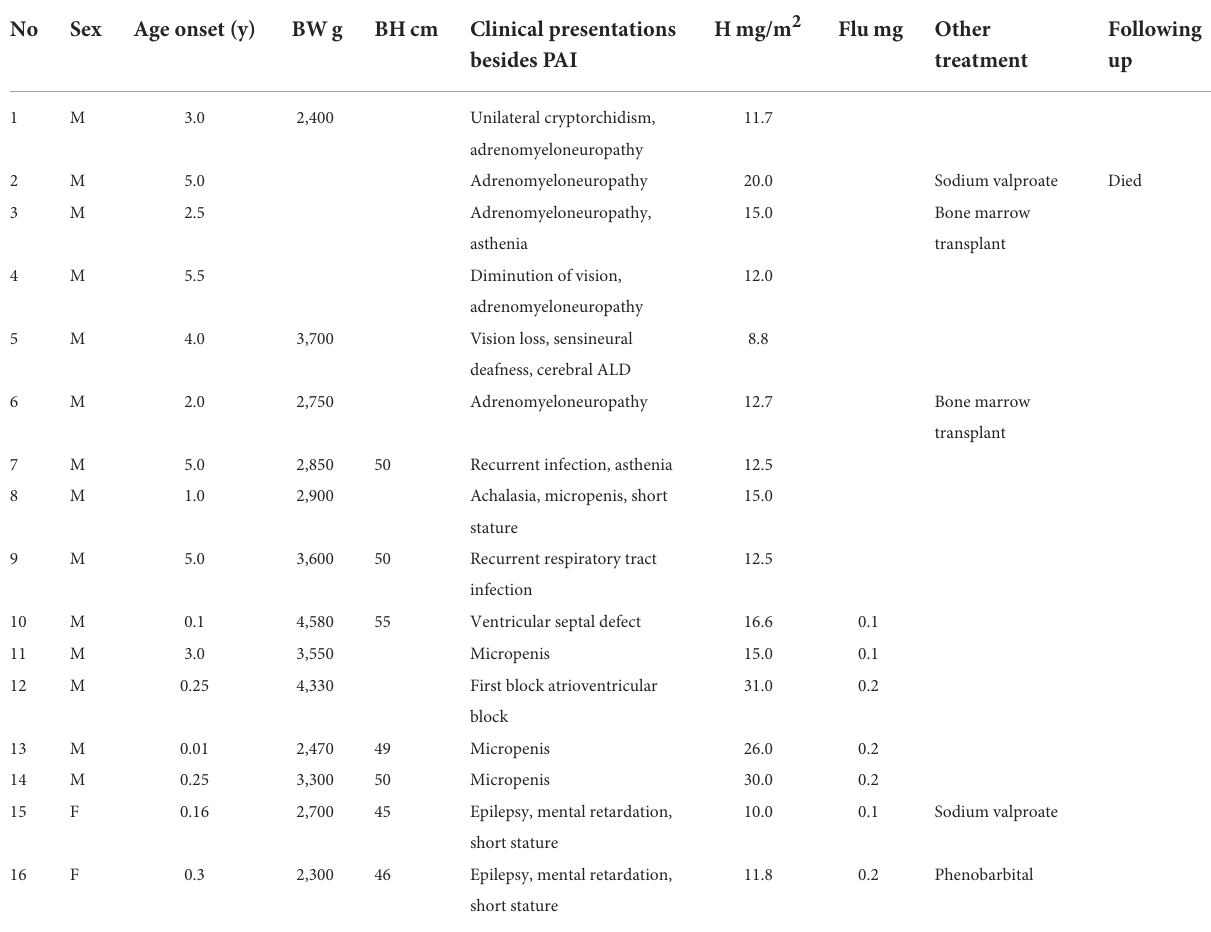
TABLE 1 Clinical manifestations of patients with